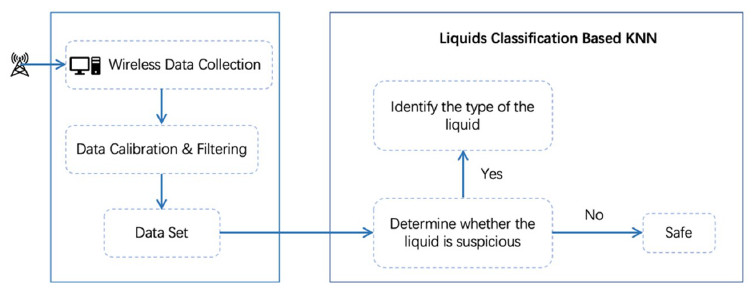
Figure 2. Method flow chart. KNN, K-Nearest Neighbor.